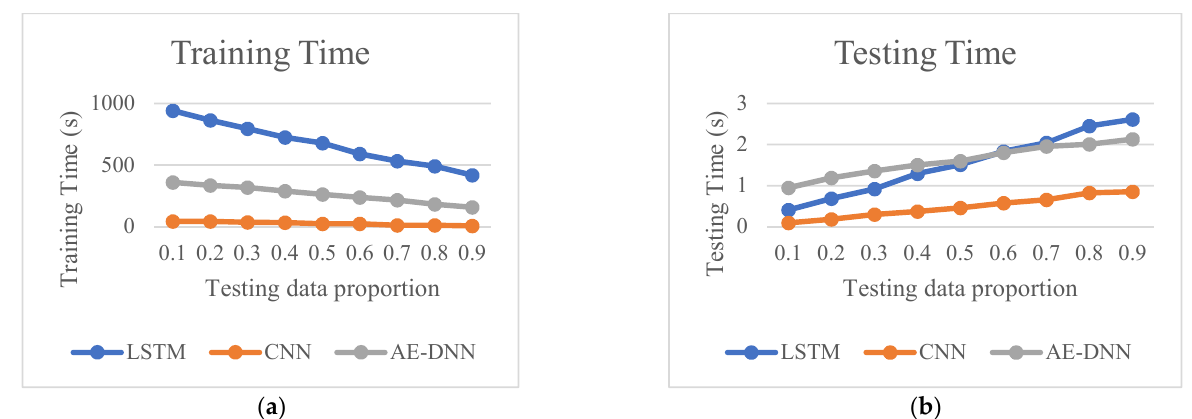
Figure 10. Comparison of classification accuracy.